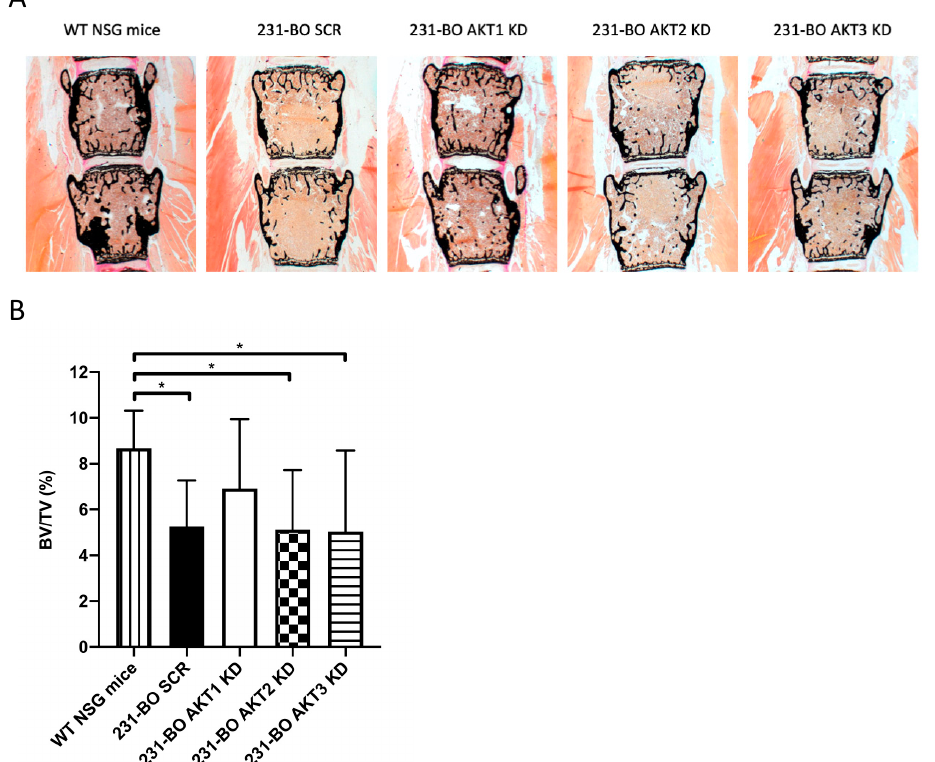
Figure 7. Knockdown of AKT3 in 231-BO cells does not enhance osteolysis in lumbar vertebral bodies after intracardiac injection: ( A ) Lumbar vertebrae bodies 1 to 5 were harvested from sacrificed mice after intracardiac injection of 231-BO cells with AKT isoform knockdowns and embedded in methylmetacrylate. Slices were stained with von Kossa/van Gieson staining to determine calcified bone volume. ( B ) Calcified bone volume was quantified relative to total tissue volume. WT NSG mice without tumor cell injection serve as a control (SCR, AKT1 KD, AKT2 KD, and AKT3 KD n = 25; WT NSG mice n = 6). Bars indicate mean with SD; * = p < 0.05.